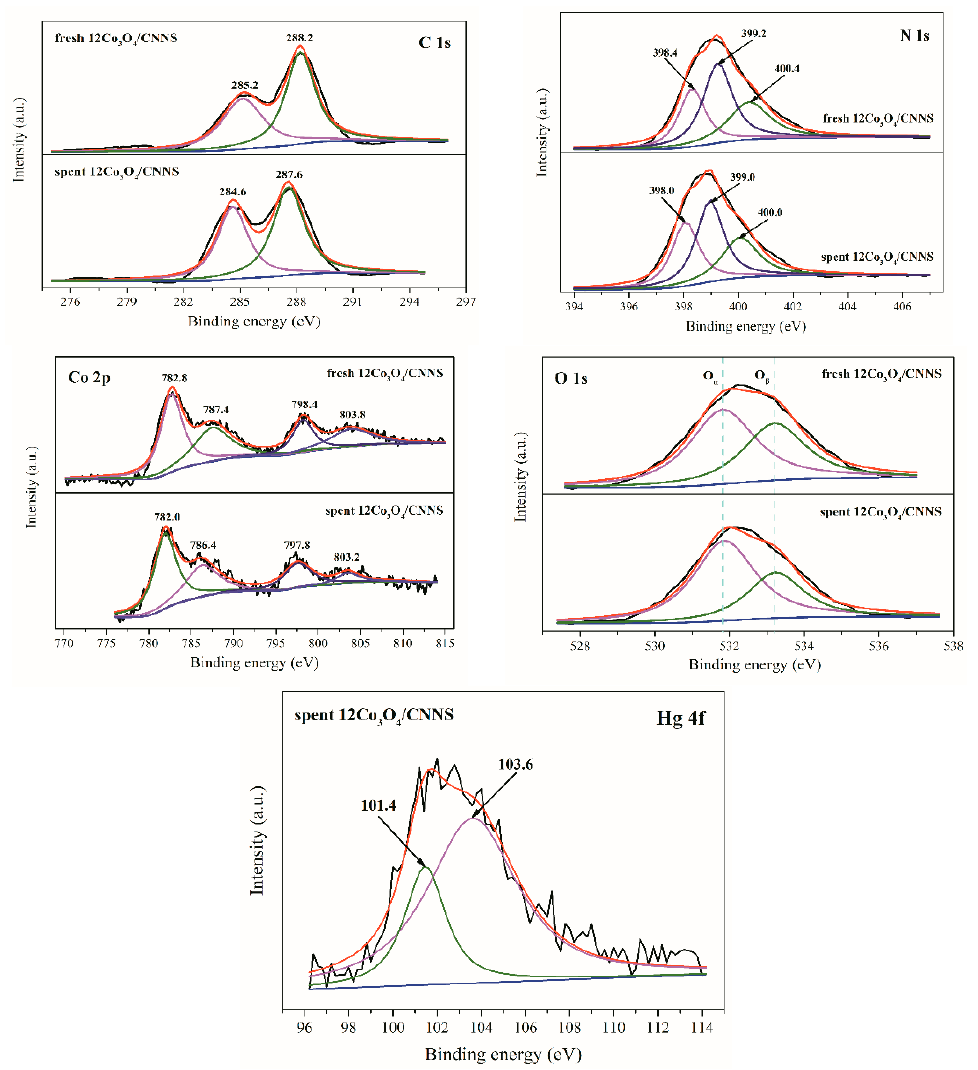
Figure 7. XPS spectra of 12Co 3 O 4 /CNNS before and after the reaction.